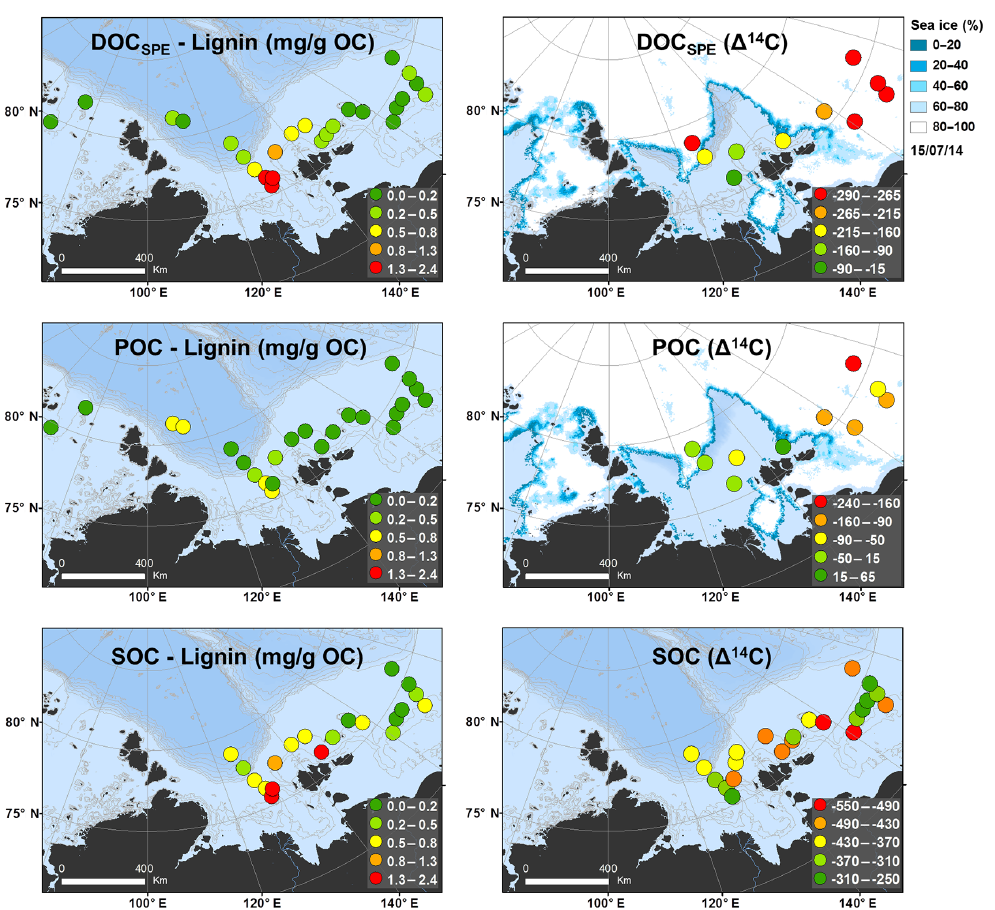
Figure 4. Spatial distribution of lignin (mgg − 1 OC) and (cid:49) 14 C signatures in the DOC SPE , POC (surface water samples at 8m depth) and SOC pools of the ESAS. Sea ice (%) during the first sampling day in the ESAS (15 July